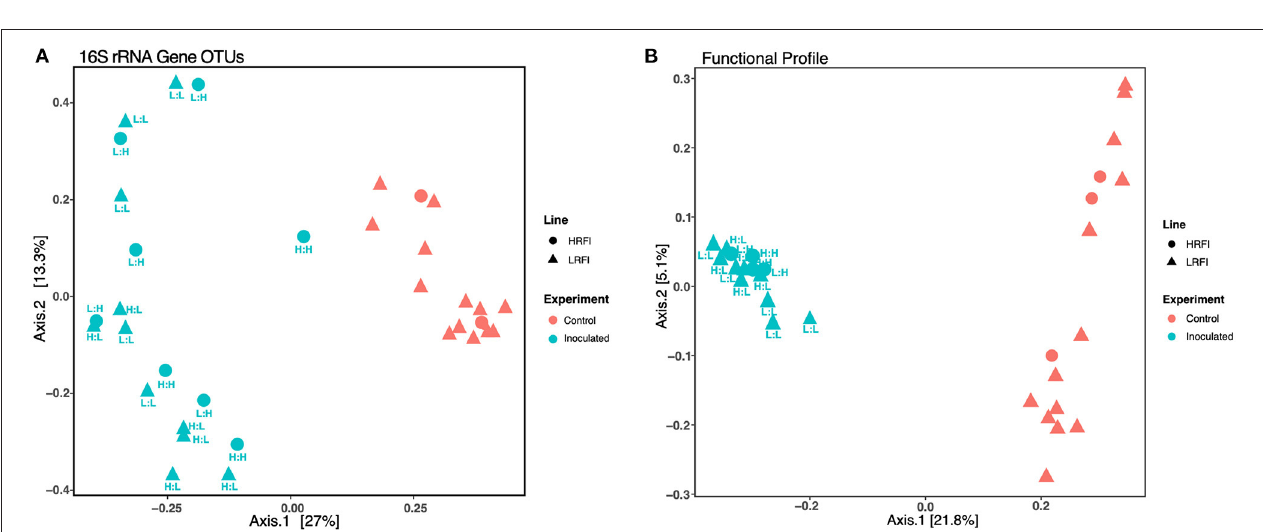
FIGURE 2 | Cecal microbial community structure based on (A) 16S rRNA gene OTU frequencies and (B) metagenomic functional gene profiles. High and low RFI bird lines depicted as circles and triangles, respectively. Color depicts the inoculation state of the bird: coral = controls (not inoculated) and teal = inoculated. All inoculated samples are also labeled with the genetic line (L: low RFI and H: high RFI) of the FMT donor and recipient, respectively. For both 16S rRNA-based microbial community structure and for functional profiles, differences between inoculated vs. uninoculated groups were significant ( p < 0.01) as determined by Benjamini-Hochberg corrected PERMANOVA analysis as further described in the Supplemental Materials